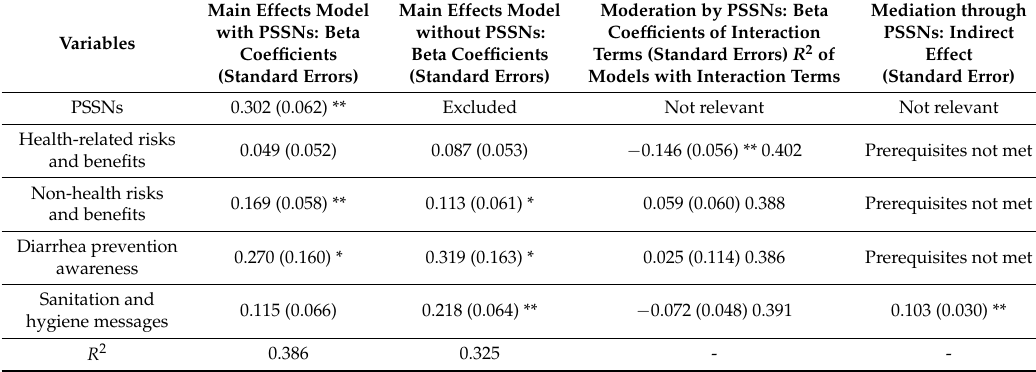
Table 3. Predictors of sanitation